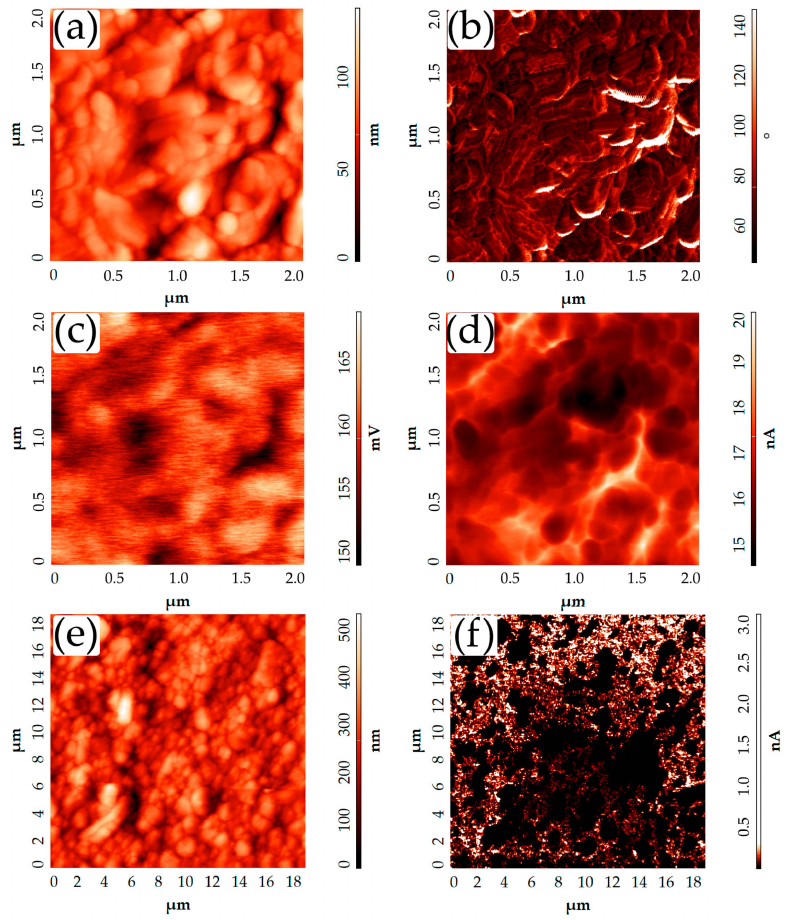
Figure 6. Results of AFM of V 2 O 5 film on PAP: topography in the semicontact mode ( a ), image in the phase contrast mode ( b ), surface potential distribution map (KPFM) ( c ), capacitor tip-sample microregion capacitance gradient distribution map (SCM) ( d ), topography during SSRM recording ( e ), current distribution between probe and sample (3 V bias voltage) (SSRM) ( f